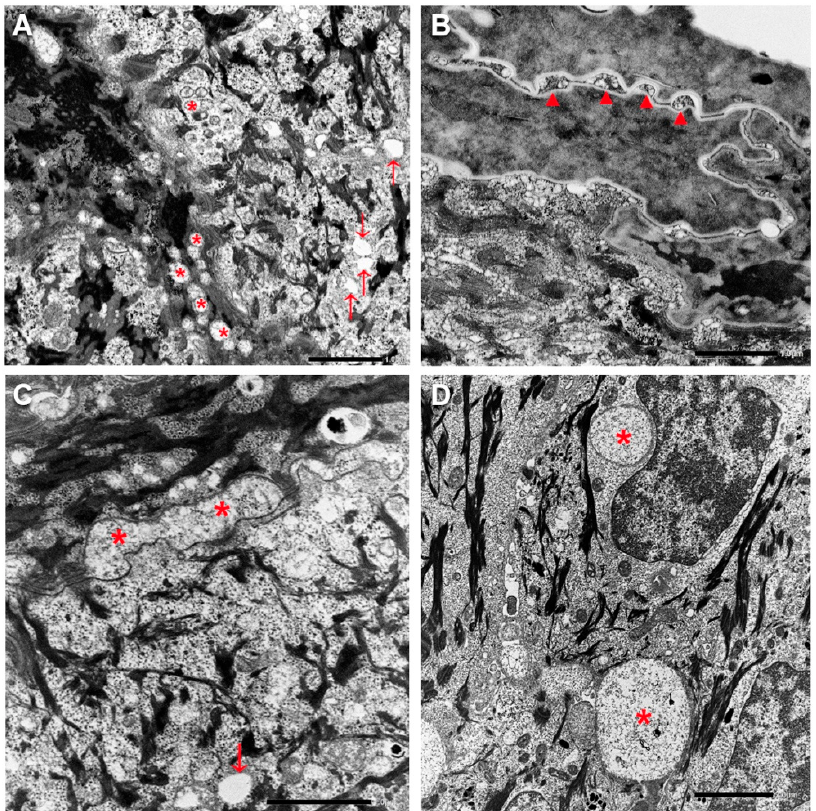
Figure 3. Ultrastructural features. Abnormal lamellar bodies with disorganized and disrupted lamellar content (asterisks) and some empty vacuoles (arrows) within the upper spinous and granular layer in patient 1 ( A ). Dilated horny layer intercellular spaces filled with disorganized lamellar structures (arrow) in patient 1 ( B ). Dilated intercellular spaces within the granular layer containing amorphous material in patient 2 (asterisks) and empty vacuoles (arrow) ( C ). Large membrane-bound cytoplasmic vacuoles (asterisks) with a finely granular content within the lower epidermis in patient 2 ( D ). Ba r= 1 µm in ( A – C ), 2 µm in ( D ).